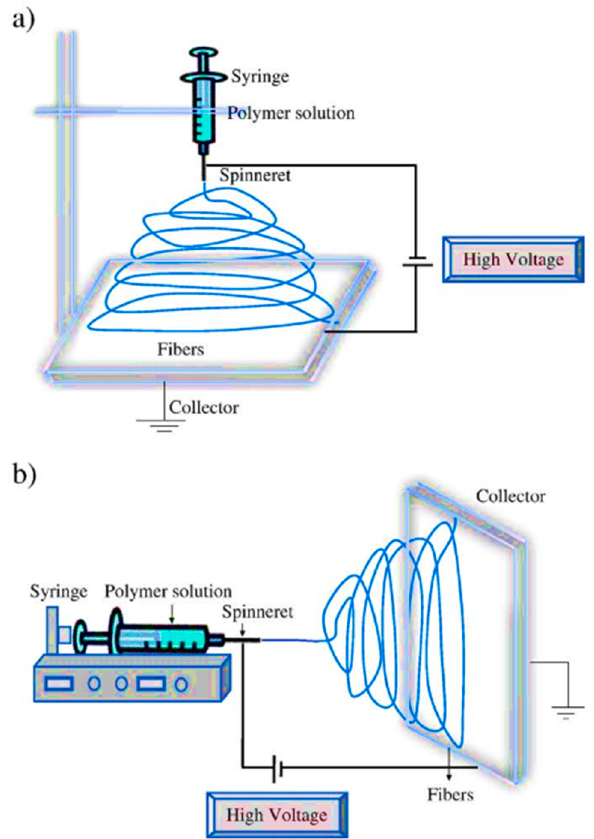
Figure 6. Schematic diagram of the electrospinning equipment ( a ) vertical and ( b ) horizontal setups. Reprinted with permission from Ref. [55], Copyright 2013 Elsevier.